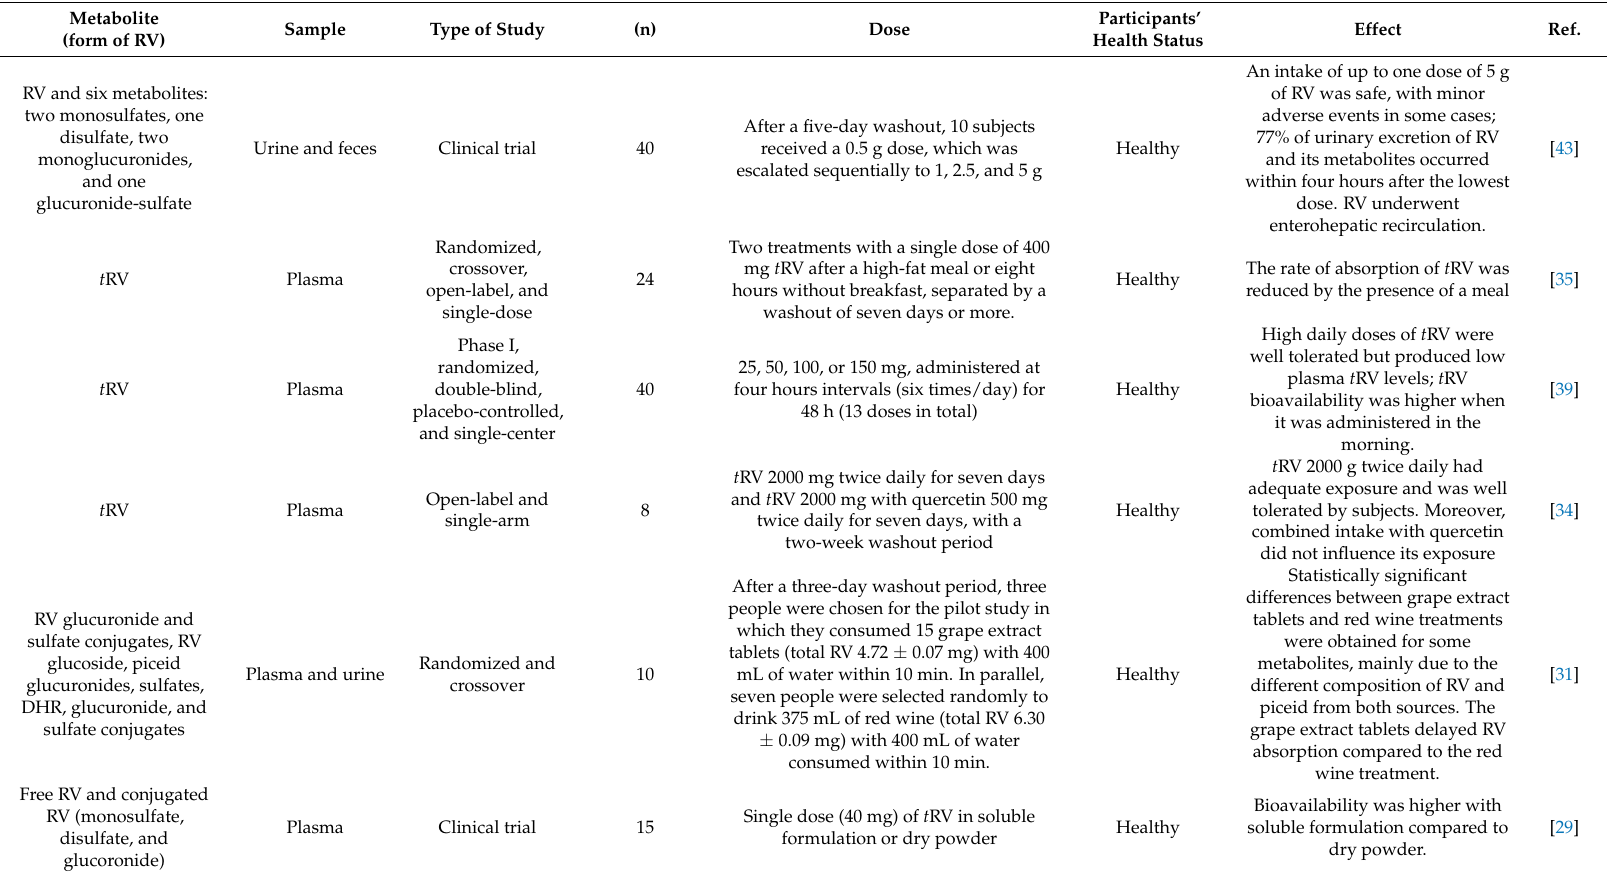
Table 1. Studies of resveratrol bioavailability and pharmacokinetics in the last 10 years